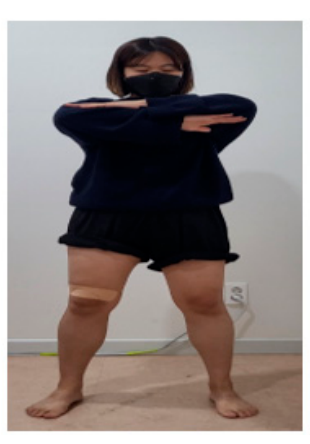
Figure 3. Kinesio taping with squat exercise.